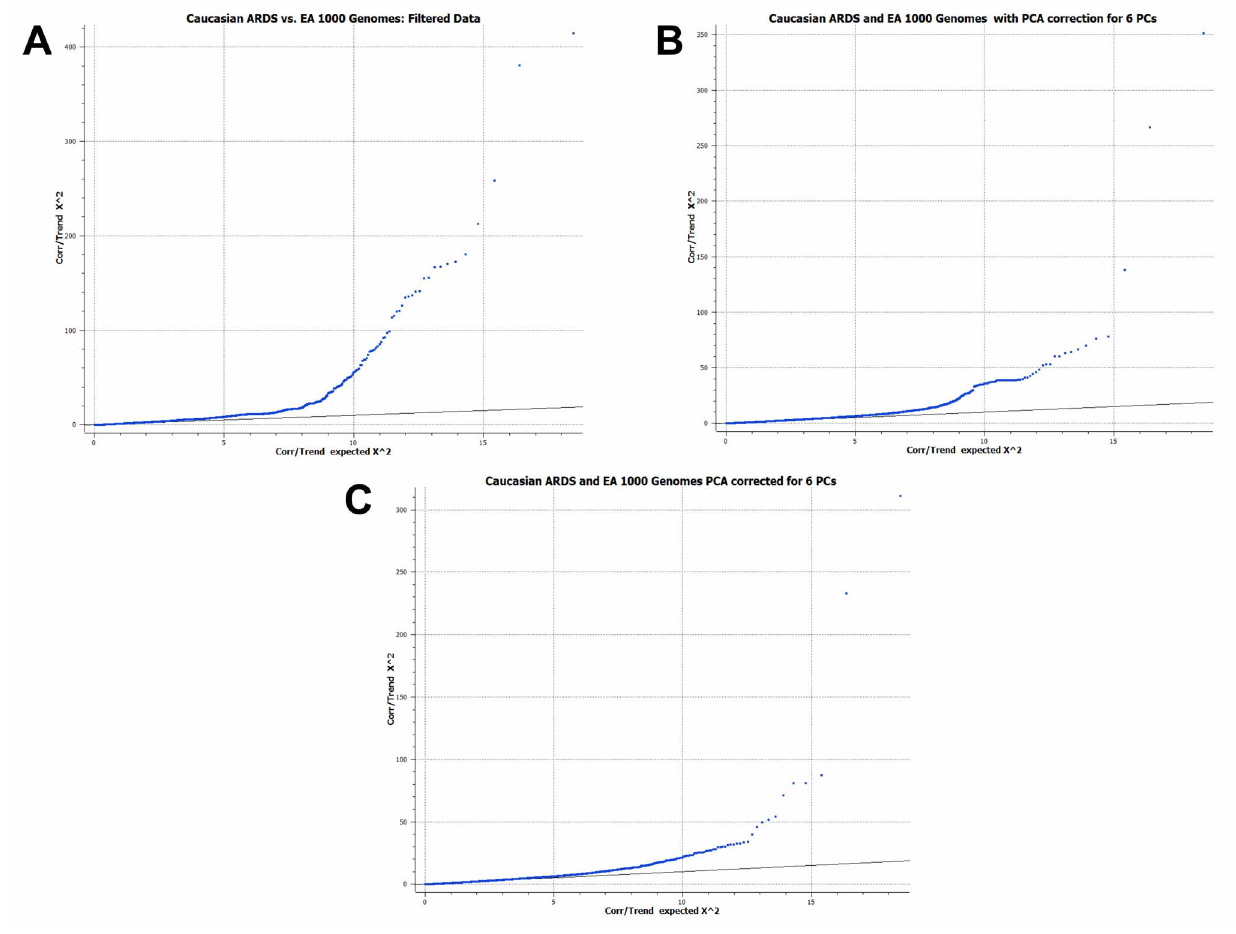
Figure 3. Quantile-quantile plots of Caucasian ARDS and EUR 1000 genomes. In the example of our Caucasian cases and EUR controls, we observe that correction for principal components improves the fit of our data with the expected distribution. ( A ) QQ plot of expected x 2 values versus the actual x 2 values for the genotypic trend test of case-control status. The data are filtered on HWE, LD, and SNP call rate but not PCA corrected. ( B ) QQ plot of expected x 2 values versus the actual x 2 values for the genotypic trend test of case-control status. The data have been filtered and corrected for 6 PCs. ( C ) QQ plot of expected x 2 values versus the actual x 2 values for the genotypic trend test of case-control status. The data have been filtered and corrected for 6 PCs and undergone sample outlier